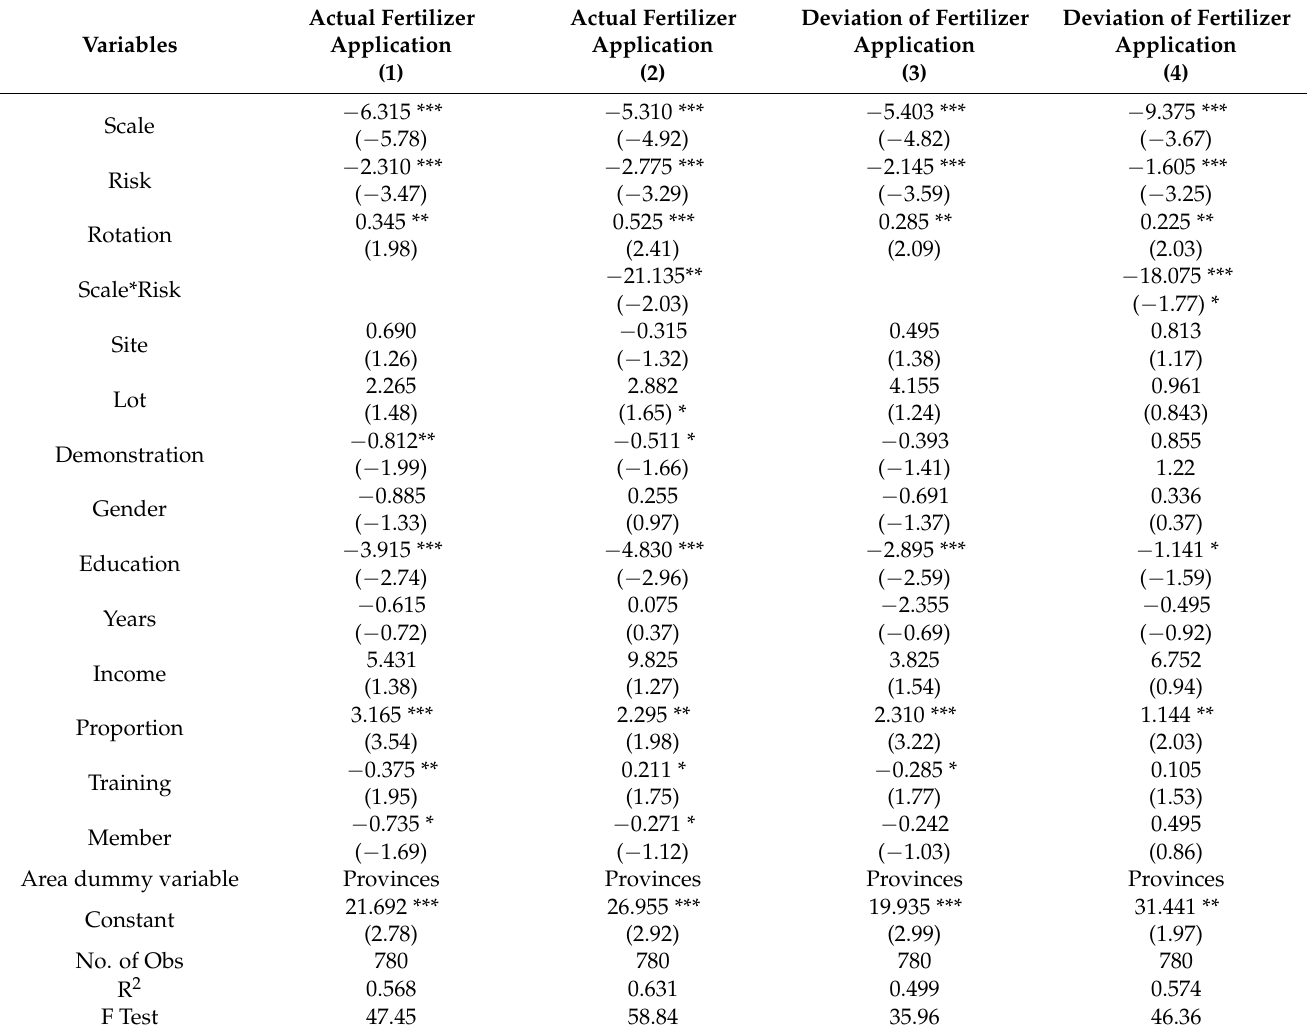
Table 7. OLS regression results of influencing factors on fertilizer